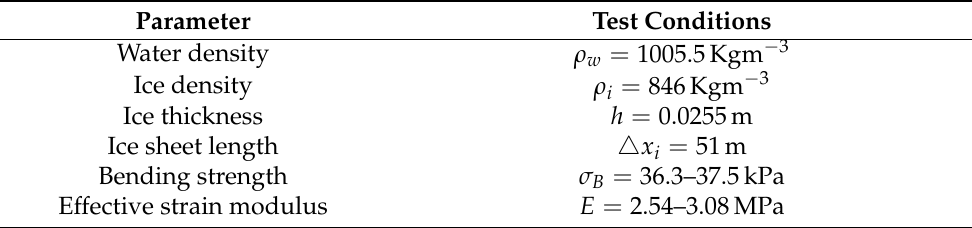
Table 1. Overview on the model ice